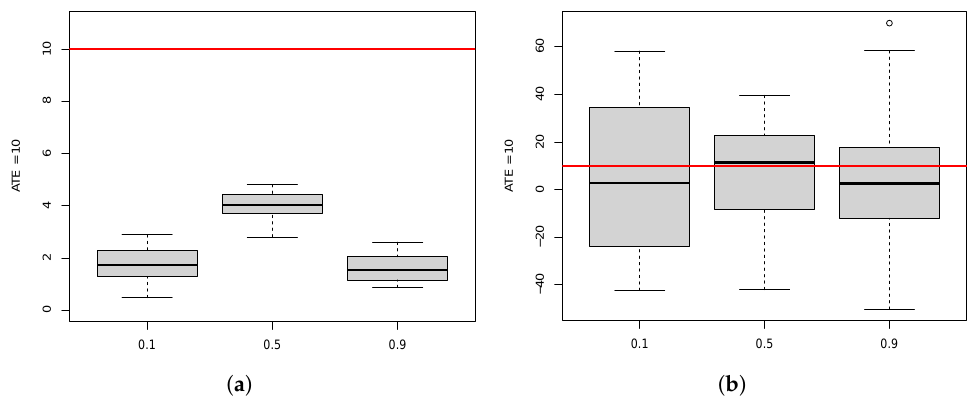
Figure 6. ATE true = 10 estimations for different participation rates for Naive method. Note that the scales of the two figures are not the same. ( a ) Naive linear. ( b ) Naive